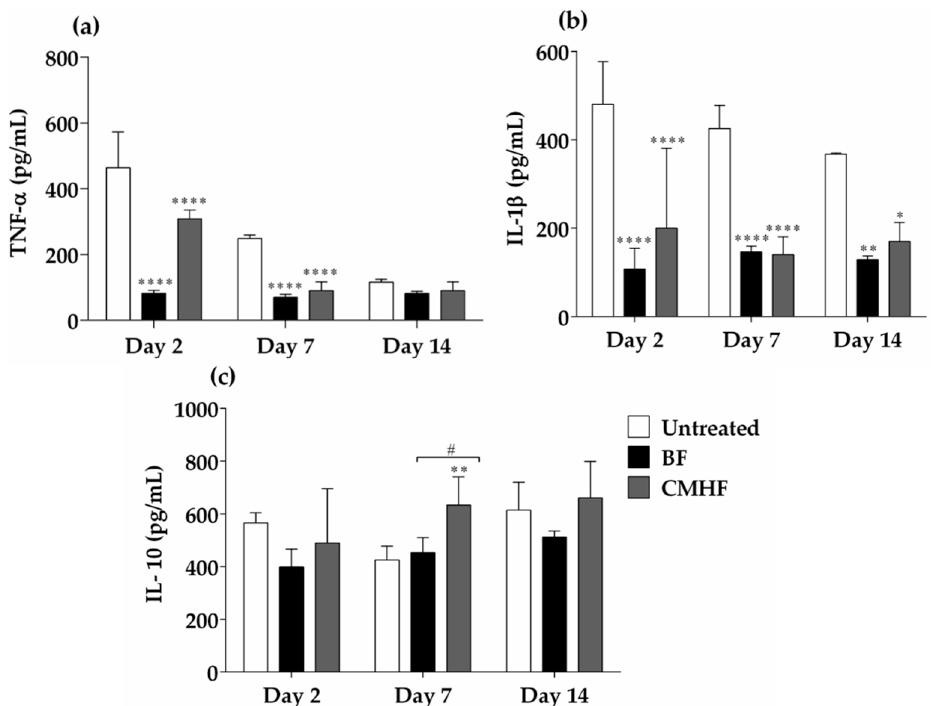
Figure 11. Cytokine analysis. ( a ) Cytokine TNF- α expressed on the untreated, BF, and CMHF groups using an enzyme-linked immunosorbent assay. ( b ) Cytokine IL-1 β expressed on the untreated, BF, and CMHF groups using an enzyme-linked immunosorbent assay. ( c ) Cytokine IL-10 expressed on the untreated, BF, and CMHF groups using an enzyme-linked immunosorbent assay. Statistical di ff erence demonstrated by ANOVA analysis followed by Tukey post-test. Data represents the mean of the values obtained from three animals and the vertical lines indicate the standard deviation. **** p < 0.0001, ** p < 0.01, and * p < 0.05, for comparison between the untreated and BF groups; # p < 0.05 for comparison between the BF and CMHF groups.